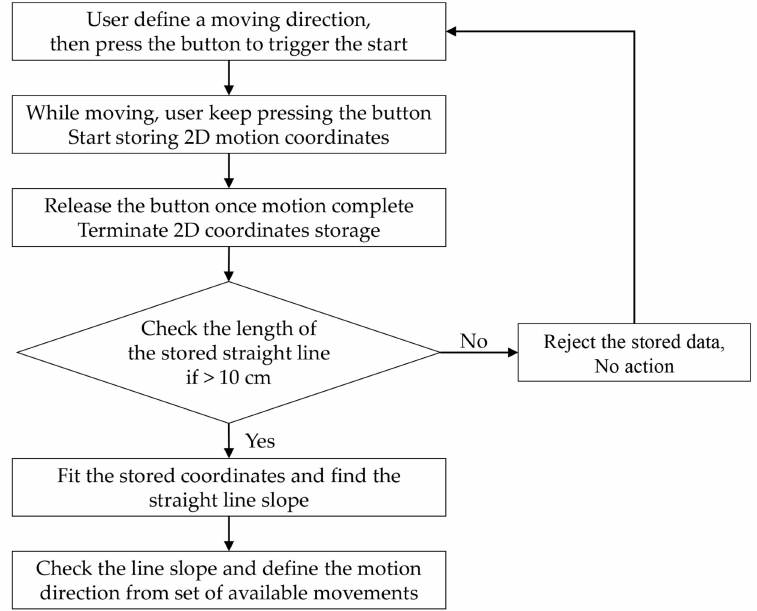
Figure 6. Detect the motion direction while performing